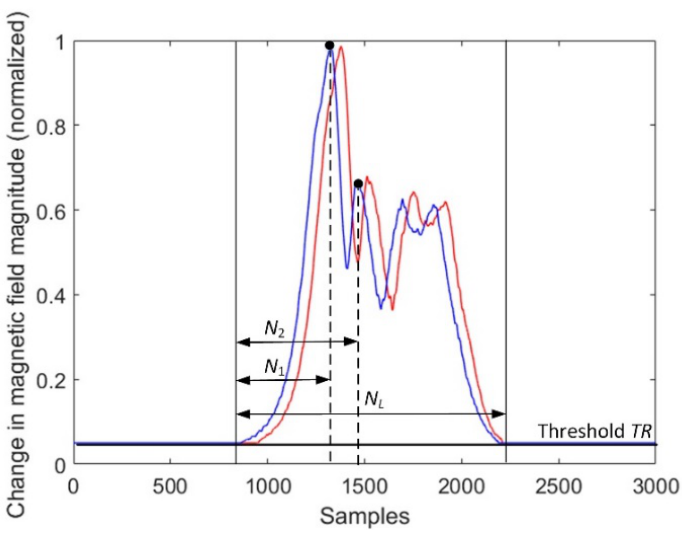
Figure 6. The effect of diminishing the sample size N to N 2 ; N L is the number of samples above a fixed threshold.